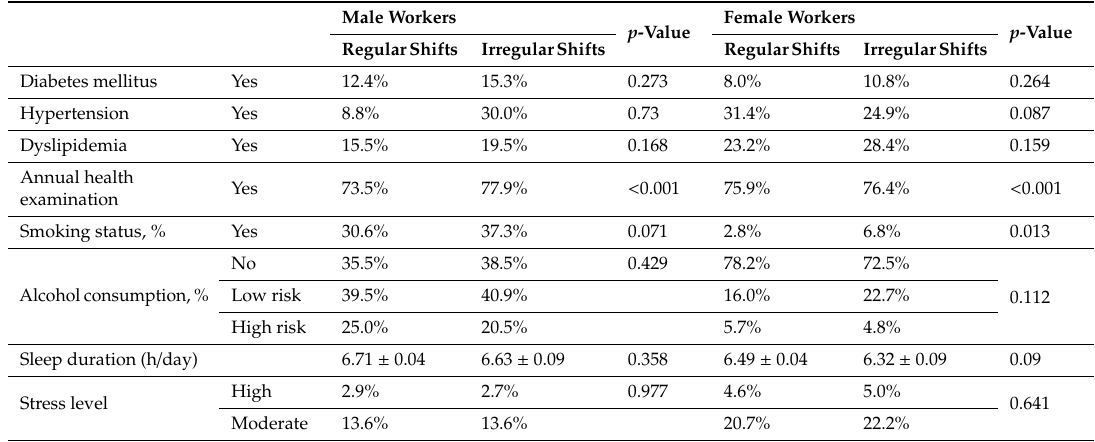
Table 2. Health behaviors and lifestyle conditions according to gender and work pattern. Male Workers Female Workers p -Value p -Value RegularShifts IrregularShifts RegularShifts